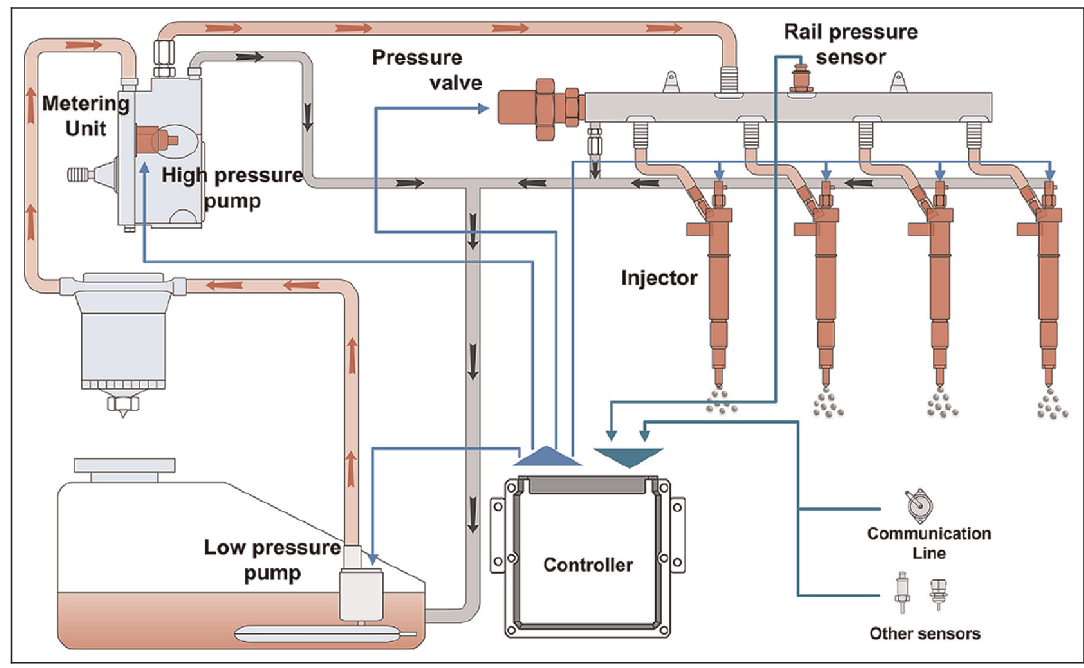
Figure 3. Layout schema of high-pressure common-rail (HPCR)